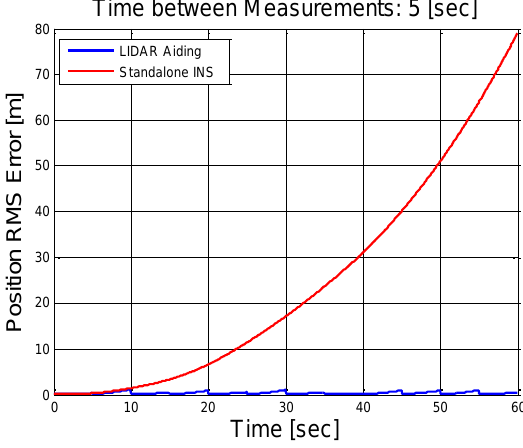
Figure 2: Position error for lidar aiding versus standalone